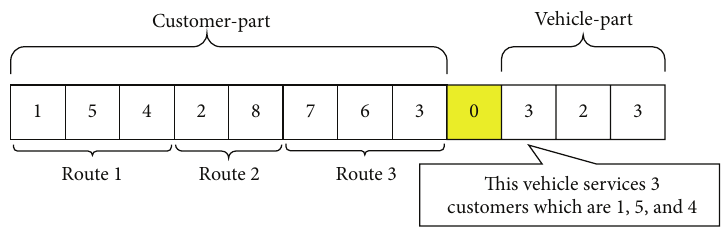
Figure 1: An example of a